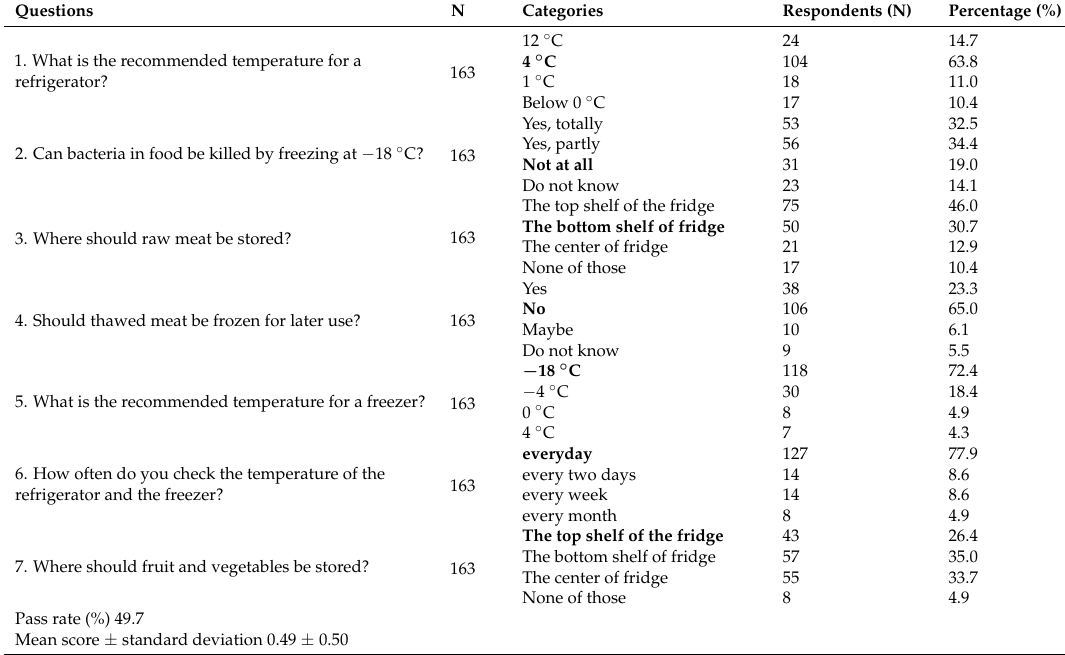
Table 5. Knowledge of foodservices staff of food